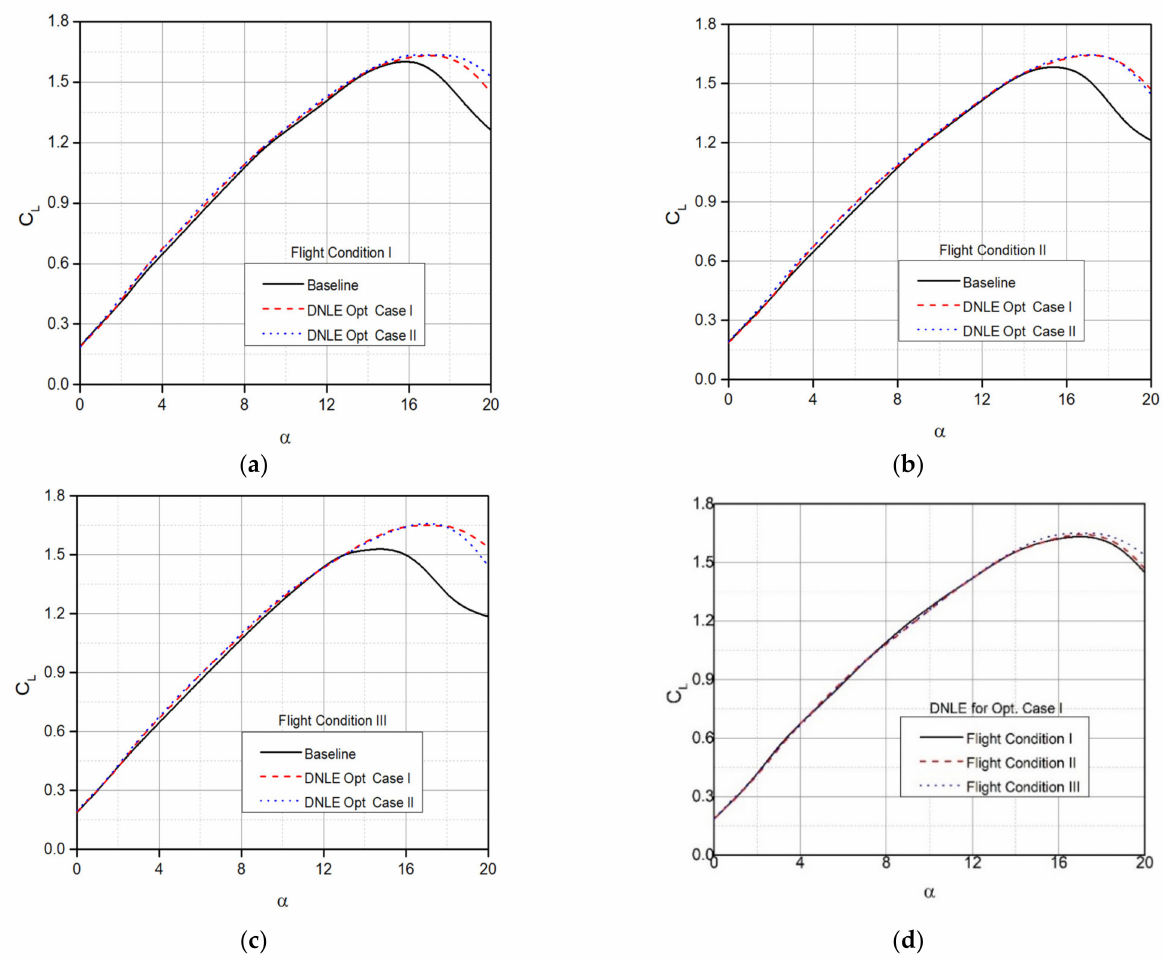
Figure 13. Lift coefficients versus angle of attack at two optimized design configurations; ( a ) Figure 13a show the variations of lift coefficients with the angles of attack at Flight Condition I ( b ) the variations of lift coefficients with the angles of attack at Flight Condition II; ( c ) the variations of lift coefficients with the angles of attack at Flight Condition III; ( d ) the lift coefficient variations for all three flight conditions for Opt. Case